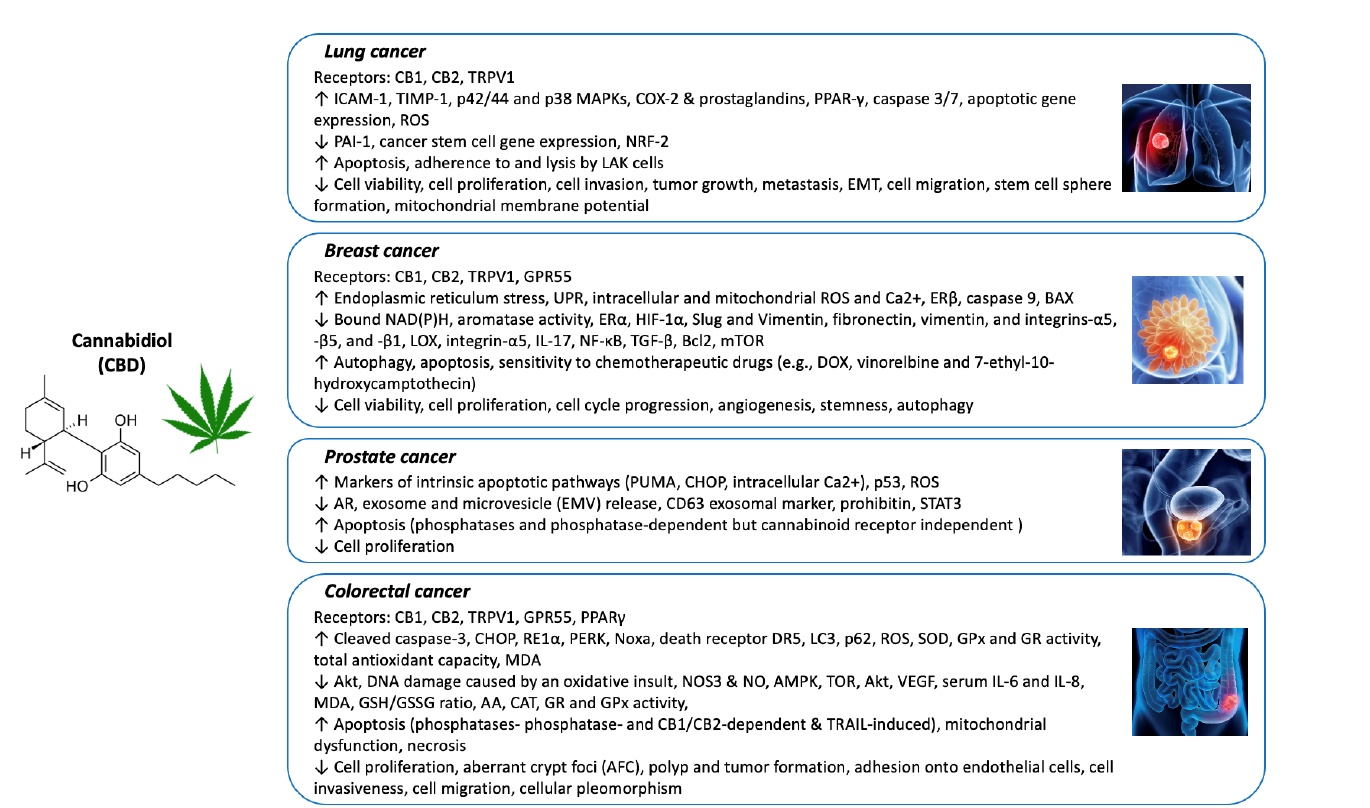
Figure 1. Major anticancer mechanisms of CBD on lung, breast, prostate, and colorectal cancers.